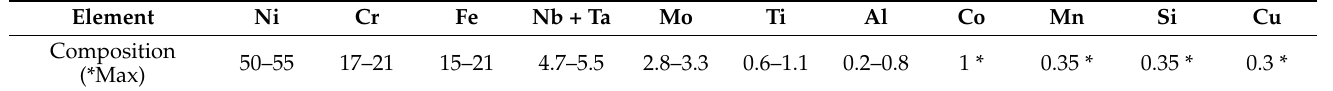
Table 5. Truform Inconel 718 metal powder chemical composition.